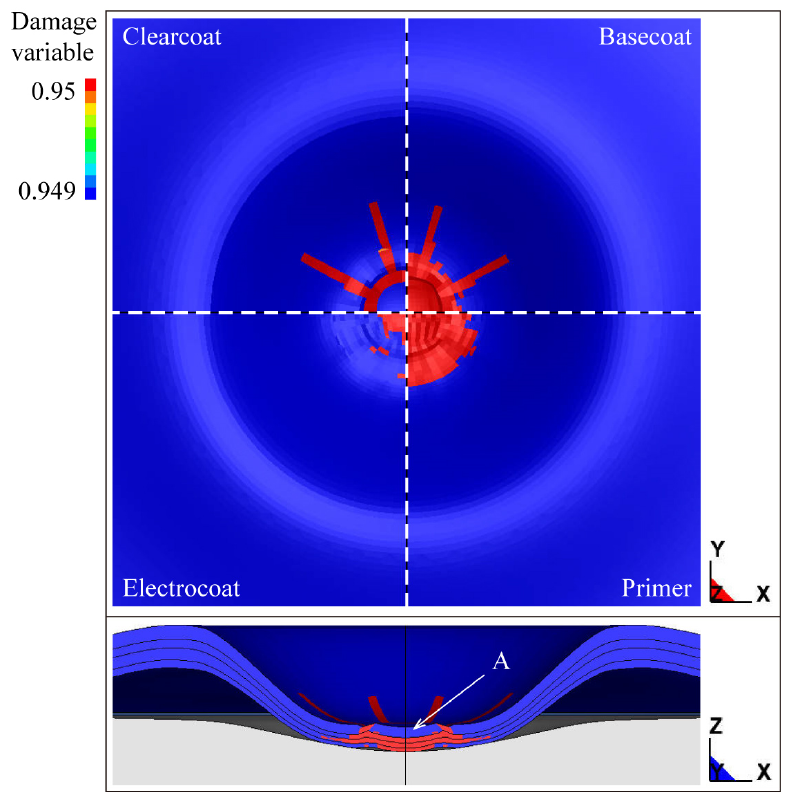
Figure 10. The predicted polymer-ply failure patterns of four paint films.